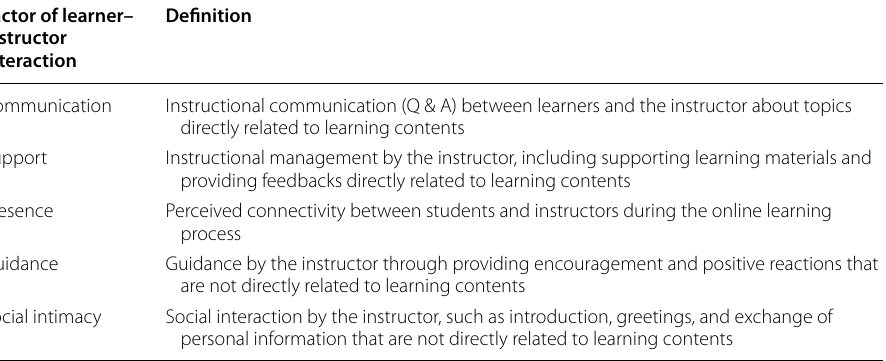
Table 1 The five-factor model of learner–instructor interaction in online learning environments, adapted from Kang and Im